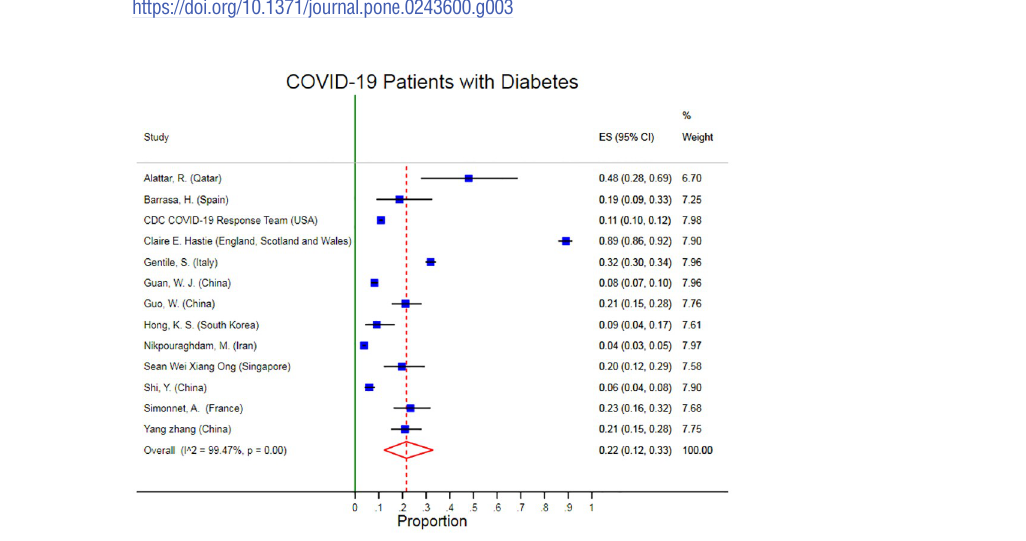
Fig 4. Forest plots of pooled prevalence of diabetes in Covid-19 patients. https://doi.org/10.1371/journal.pone.0243600.g004 PLOS ONE | https://doi.org/10.1371/journal.pone.0243600 December15,